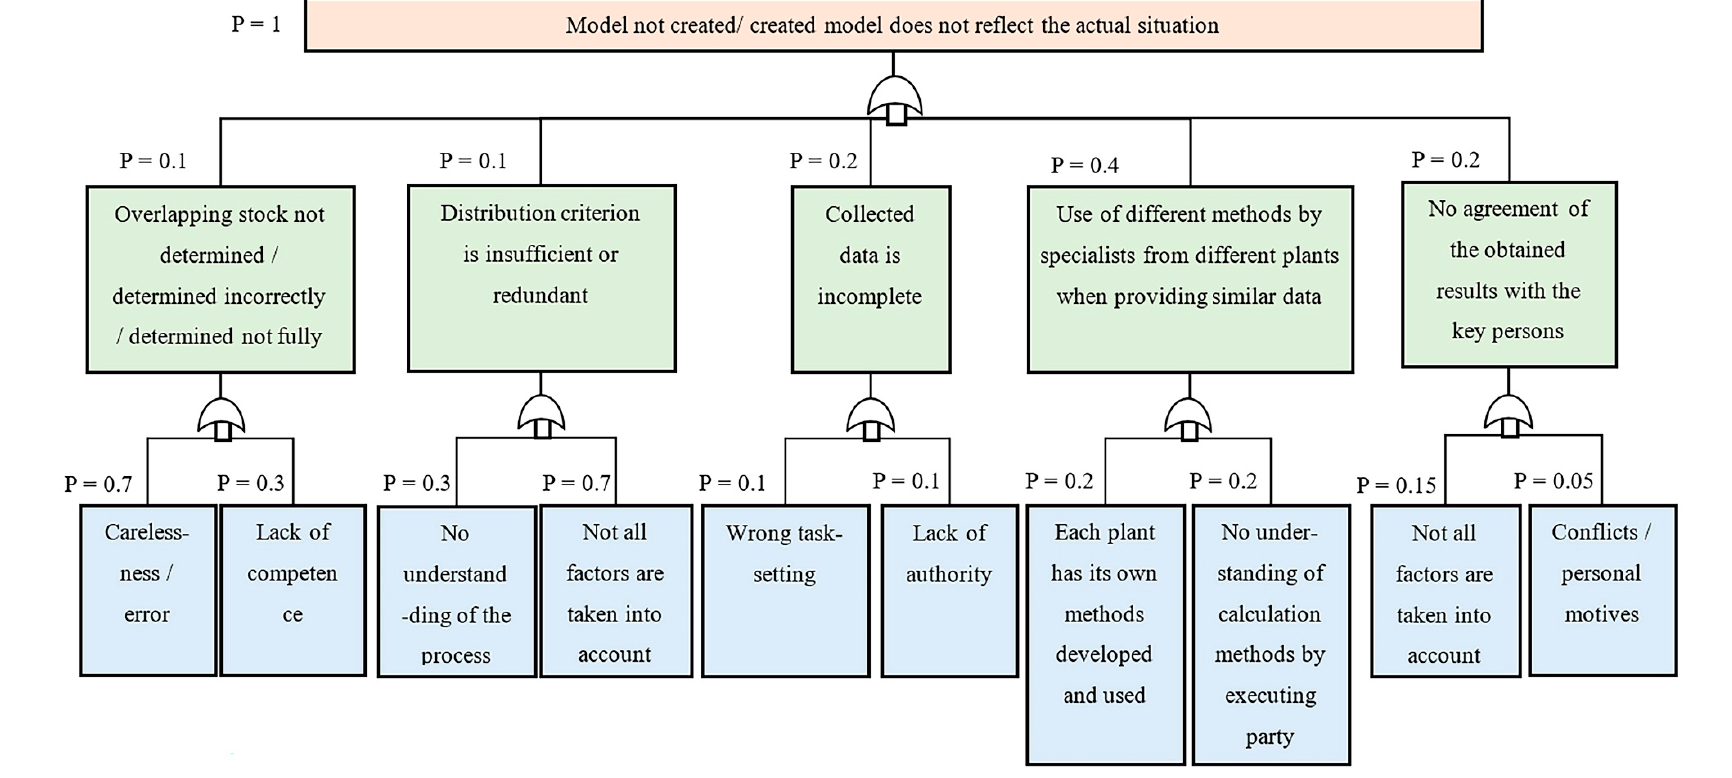
Figure 5. Fault tree for unfavorable event No.7.